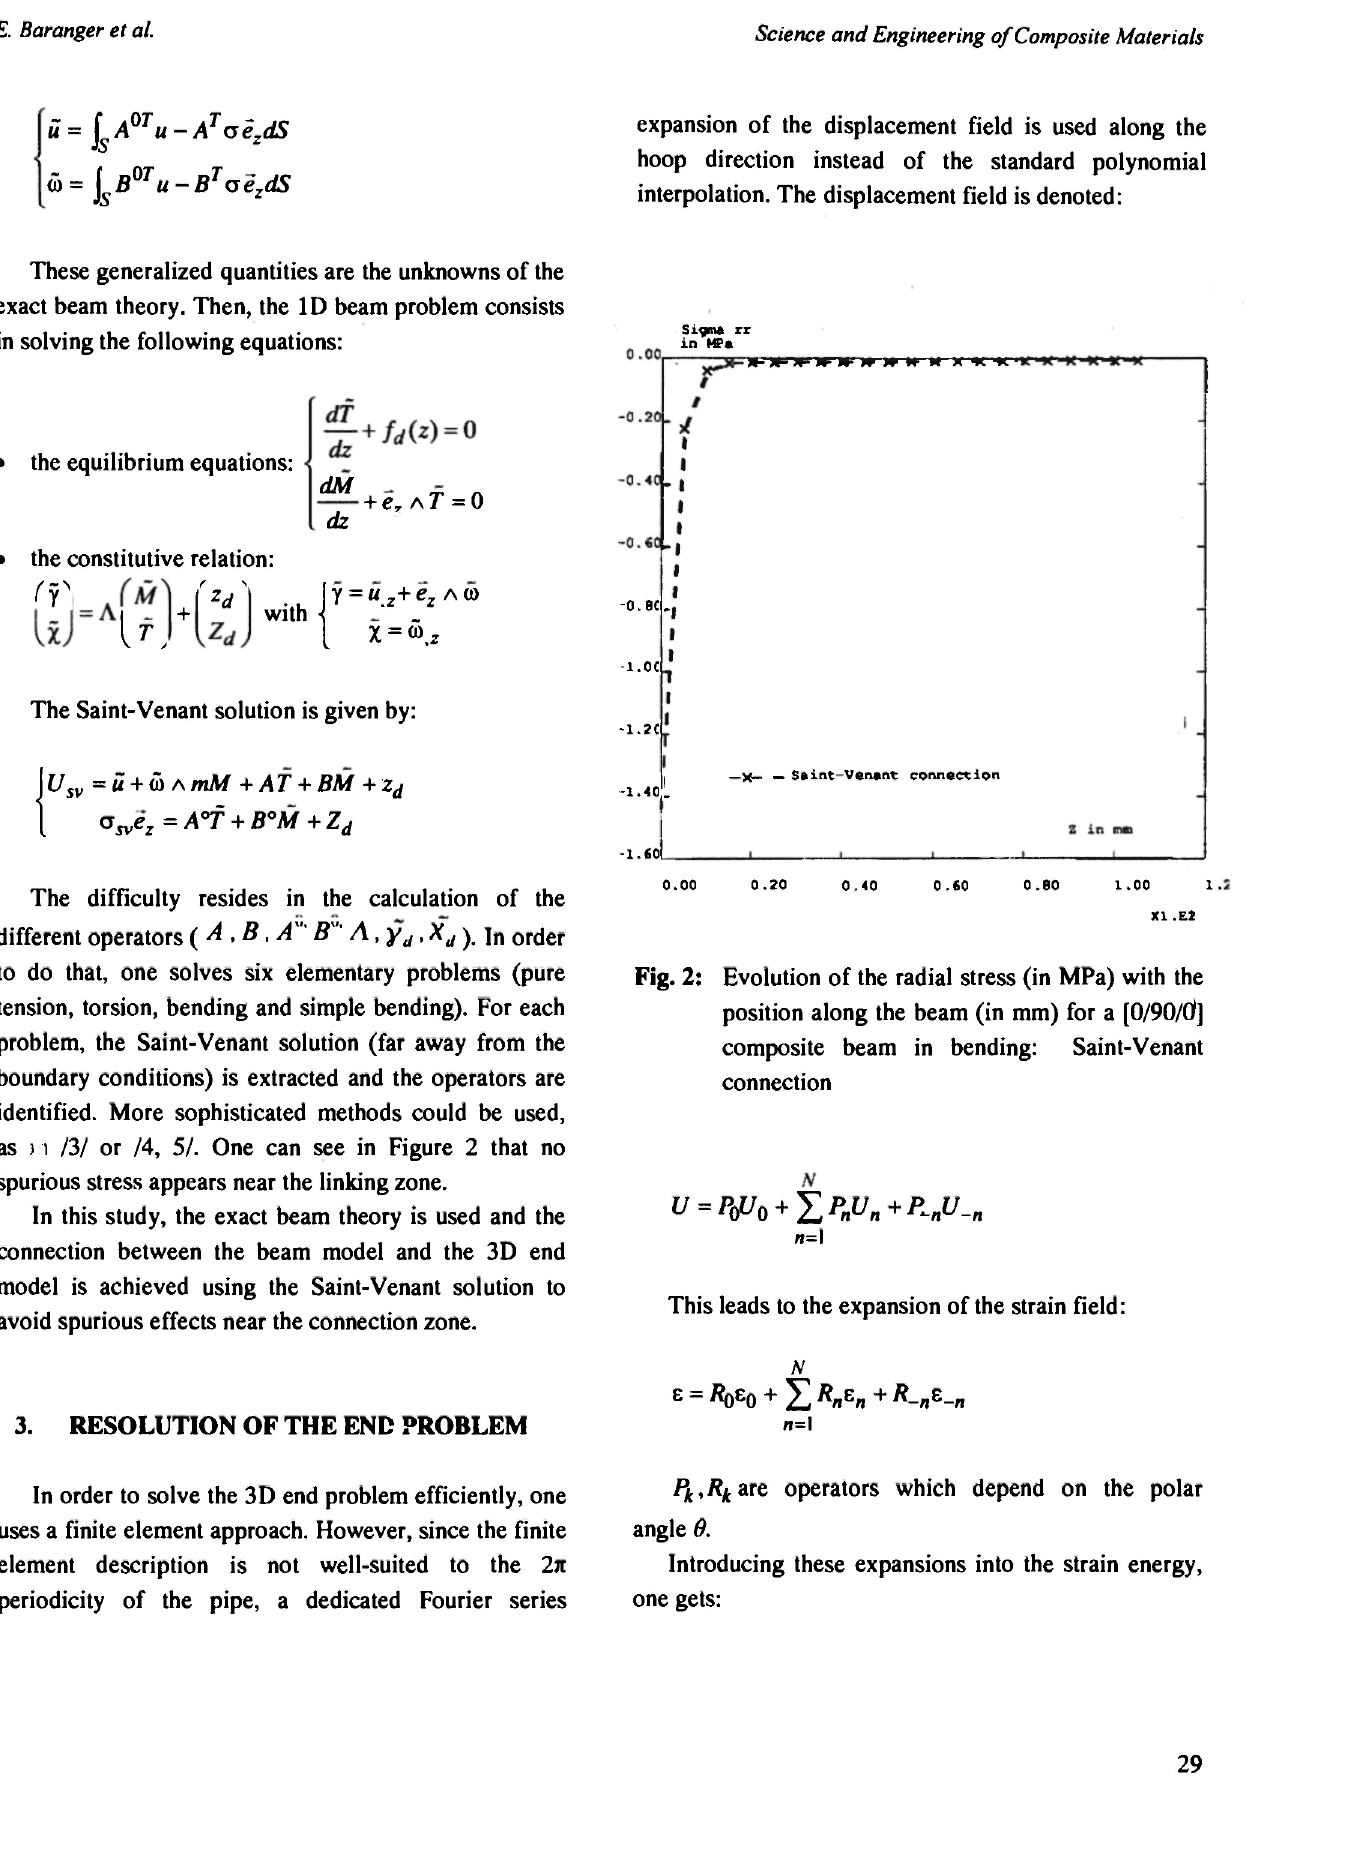
—X— — Sftint-Venant connection